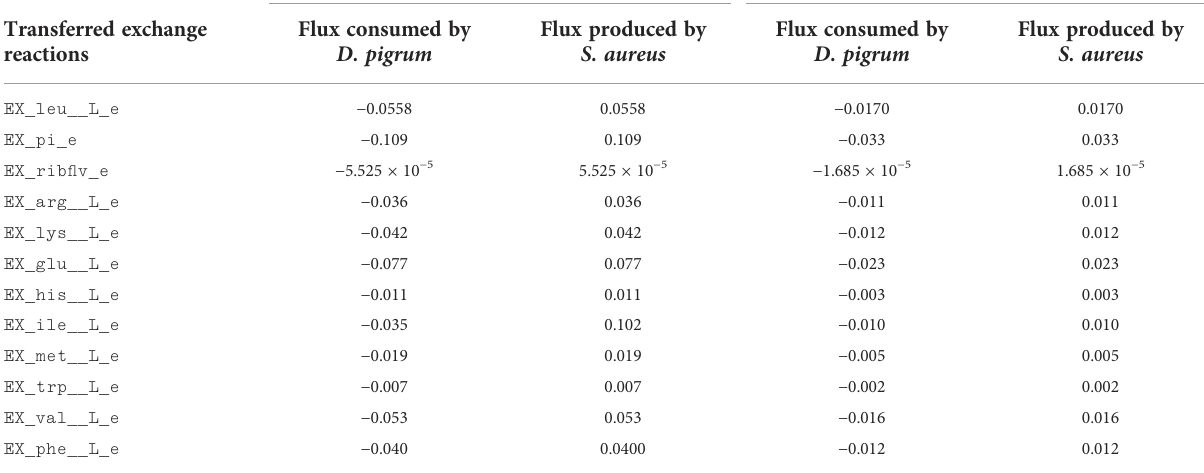
Figure 8. We calculated the effect of the change of the fl ux vector on the maximal growth. The fl ux through the exchange reaction of interest was reduced in the range of ( − 10, 0), and the objective function was calculated. All calculations have been done on the metabolic network of D. pigrum, S. aureus , and the community of both species. This helped to distinguish how one species behaves in isolation compared with being in a TABLE 4 The consumption and production of metabolites by S. aureus and D. pigrum in COOPM computed (the fl ux values are rounded by the threshold ϵ = 10 − 3 ). Flux computed using the objective function as a linear combination of growth rates of D. pigrum and S. aureus